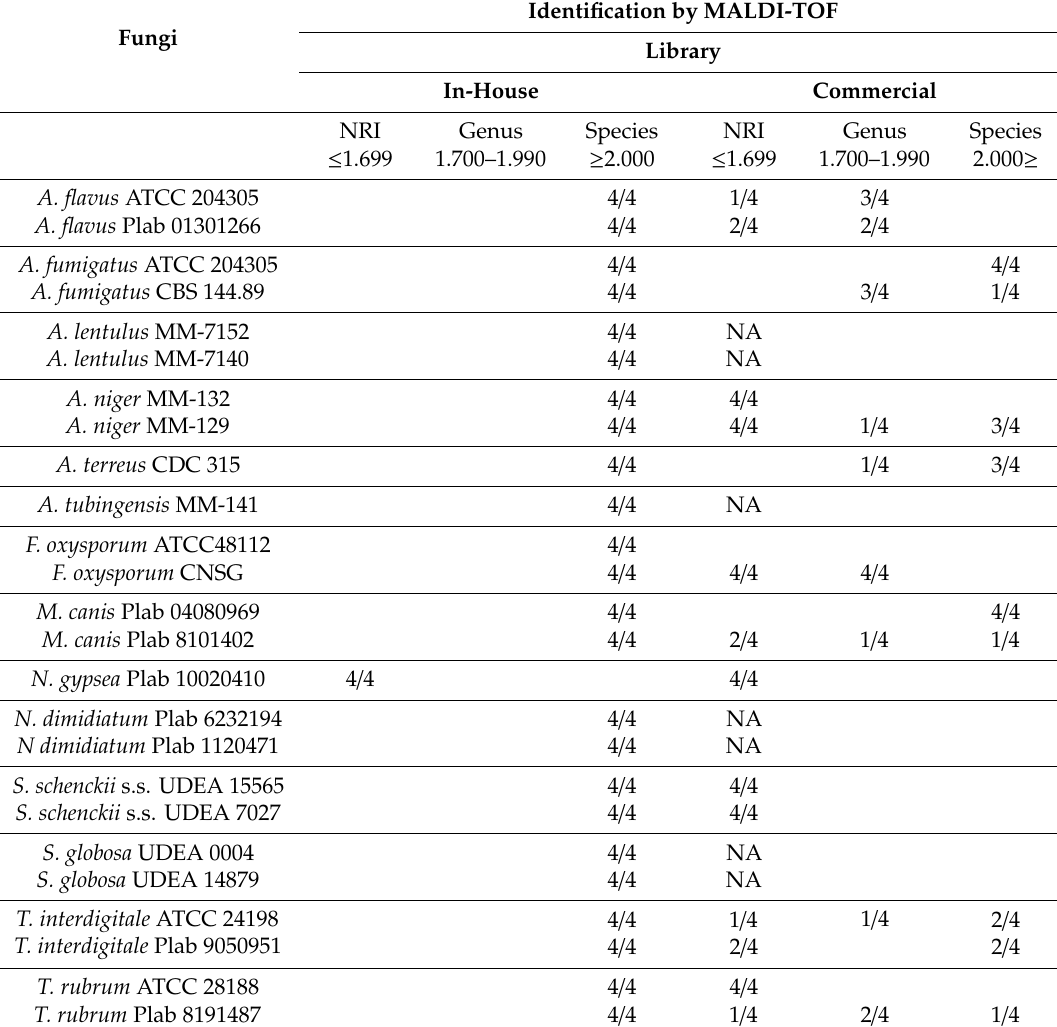
Table 3. Score values of the validation of in-house spectra library and the identification by the commercial library for 25 filamentous fungi covering 14 fungal